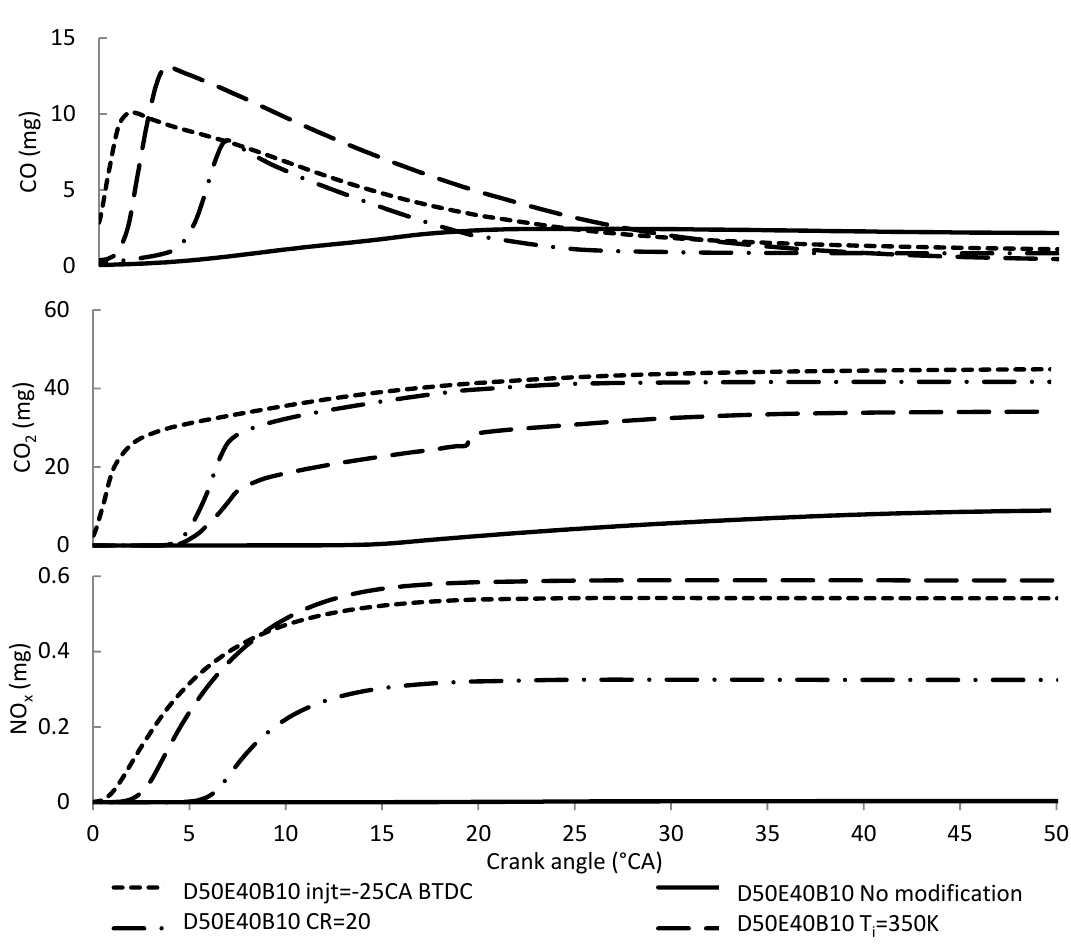
Figure 18. Comparison of CO, CO 2 , and NO x emissions of D50E40B10 blends at the best injection modification, compression ratio, and intake temperature.